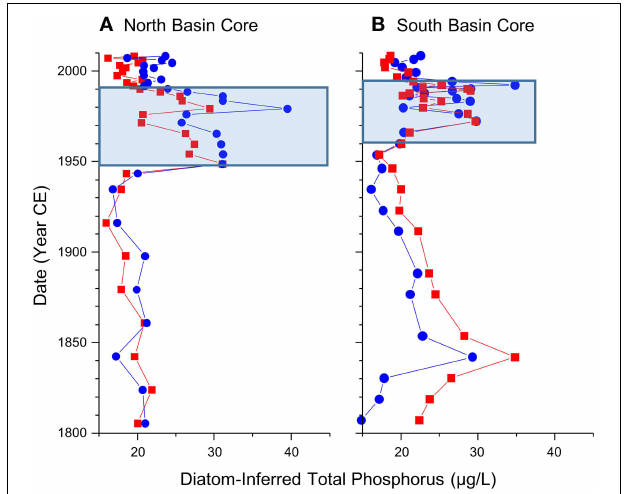
FIGURE 6 | Diatom-inferred total phosphorus values, with (in red) and without (in blue) the poorly represented diatom taxa in the calibration dataset (i.e., taxa shown in red in Figure 5) from the dated sediment cores from the north (A) and south (B) basins of Osoyoos Lake over the last 200